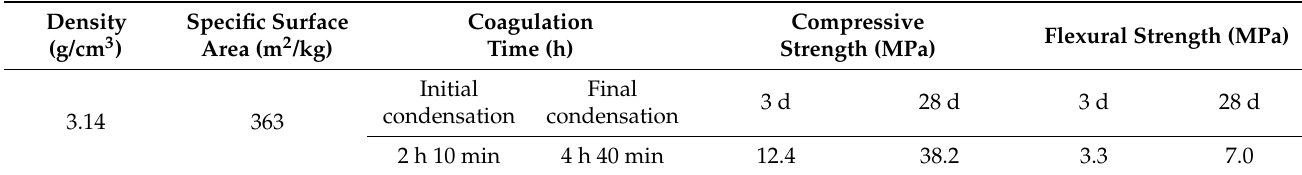
Table 1. Basic properties of the cement.